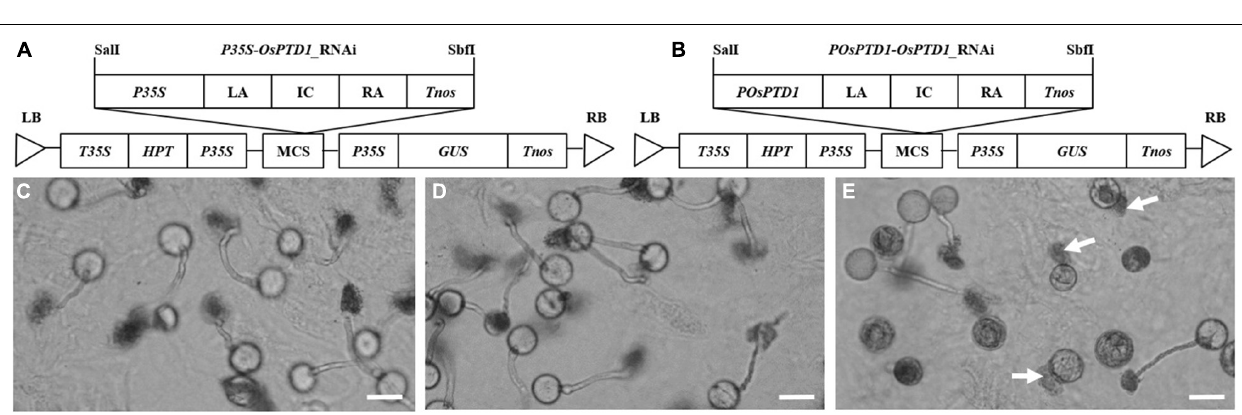
FIGURE 2 | RNAi pollen germination in vitro. (A) The structure of pP35S - OsPTD1 -RNAi. (B) The structure of pPOsPTD1 - OsPTD1 -RNAi. (C) The germination of wild pollen. (D) The germination of the P35S -promoted RNAi pollen. (E) The germination of POsPTD1- promoted RNAi pollen; arrows indicate the rupture of RNAi pollen. All images were created 30 min after germination. Scale bars, 20 µ